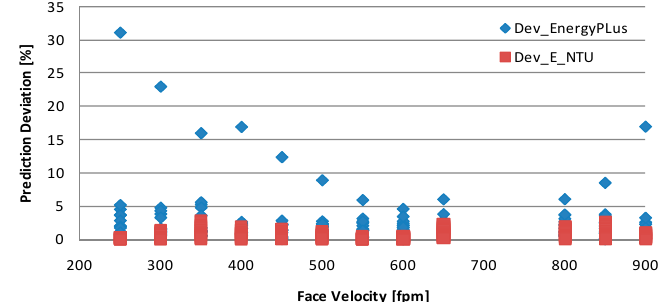
Figure 1. Relative deviations from manufacturer’s data predicted by the effectiveness-NTU model and EnergyPlus.